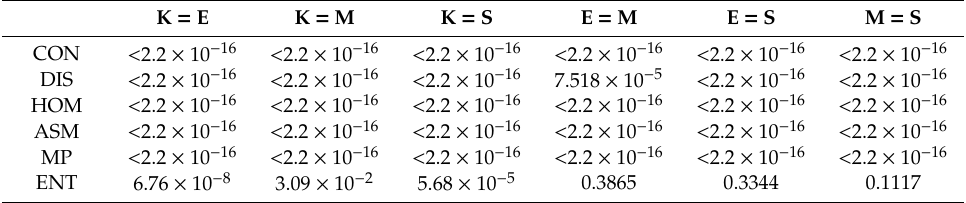
Table 7. p -values of non-parametric Mann–Whitney–Wilcoxon tests for the compared groups with fine distinction. Null hypothesis is indicated in bold letters. (abbreviations according to Table